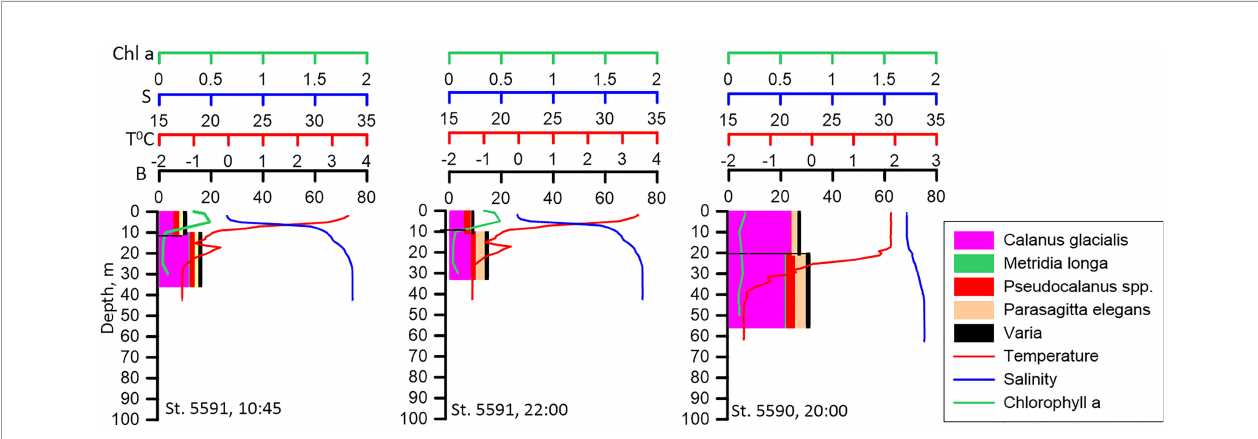
FIGURE 4 | Vertical distribution of biomass of the dominant species (B, mg DW m -3 ) at different time of the day at the neighboring stations. No diel re-distribution of biomass could be detected. Vertical pro fi les of temperature (T° C), salinity (S) and Chlorophyll a (Chl, mg m -3 ) distribution are